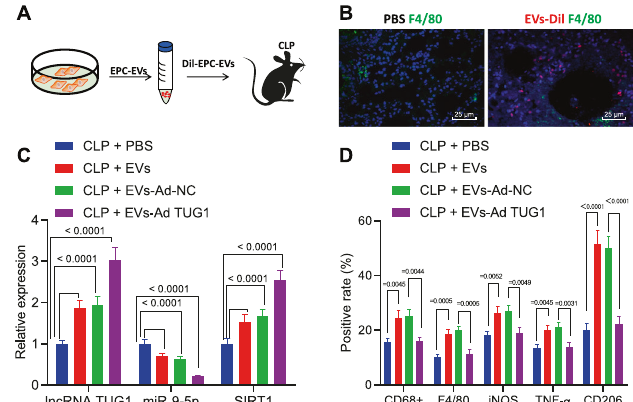
Fig. 6 EPC EVs encapsuled TUG1 promotes macrophage M2 polarization in the murine model. A Flow chart of injection of EPC-derived EVs or PBS in CLP-stimulated septic mice. B Localization of Dil staining (red) prelabeled EVs and F4/80-labeled macrophages (green) in lung tissues (scale bar = 25 μ m). C The expression of TUG1 , miR-9-5p, and SIRT1 in the lung tissues of CLP-induced septic mice injected with EPC-derived EVs determined by RT-qPCR ( n = 12). D The number of macrophages CD68 + and F4/80 + evaluated by fl ow cytometry and percentages of M1 markers iNOS and TNF- α as well as M2 marker CD206 in a single-cell suspension of whole lung tissues from the mice ( n = 12). Measurement data were expressed as mean ± standard deviation. One-way ANOVA was adopted to analyze comparison between multiple groups with Tukey ’ s post hoc test. One-way ANOVA was adopted for comparison between multiple groups followed by Tukey ’ s post hoc test. * p < 0.05 vs. CLP + PBS group; # p < 0.05 vs. CLP + EVs + Ad-NC